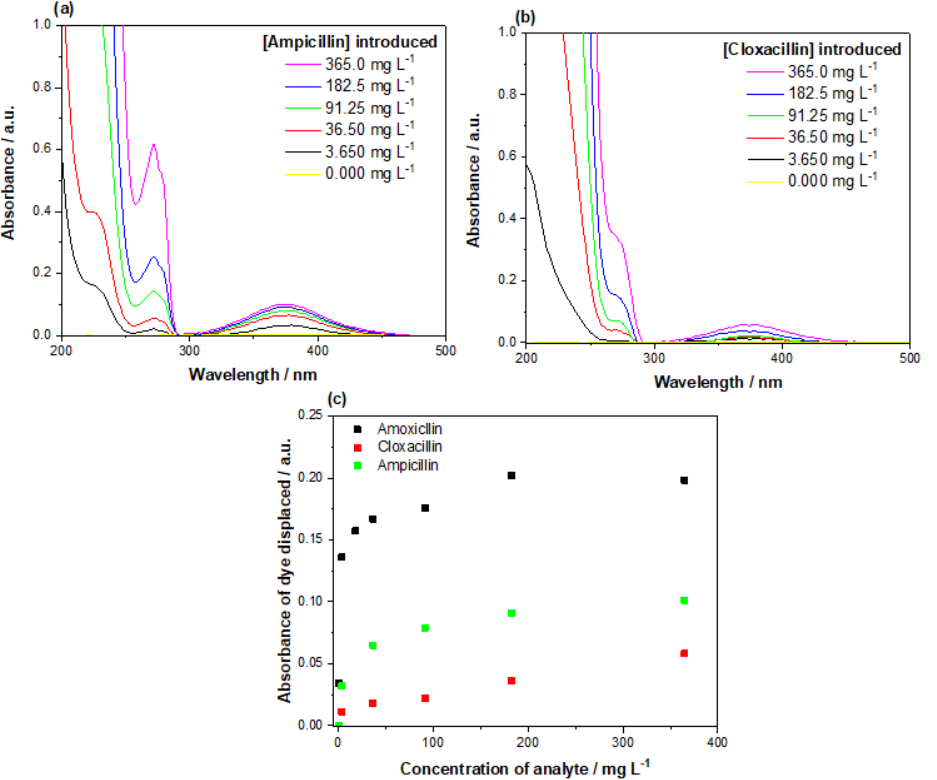
Figure 12. Dose response of the displacement assay towards ( a ) ampicillin and ( b ) cloxacillin, with the ( c ) maximum absorbance of the mordant orange dye ( λ = 385 nm) plotted against the concentration of analyte present for comparison.